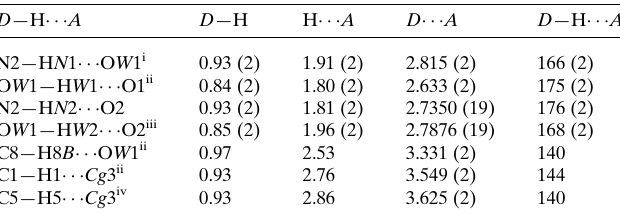
Table 2 Hydrogen-bond geometry (A˚ , (cid:3) ) for ( II ). Cg 3 is the centroid of the C12–C17 benzene ring. D —H (cid:2)(cid:2)(cid:2) A